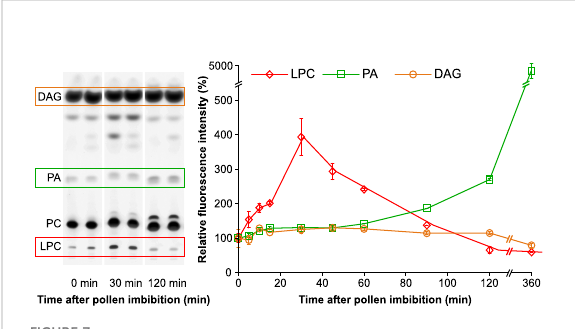
FIGURE 7 Lipid dynamics during pollen tube germination and pollen tube growth monitored by in situ analysis of PLD, PLA 2 and NPC activity. Left, pro fi les of Bodipy-labeled lipid products of pollen